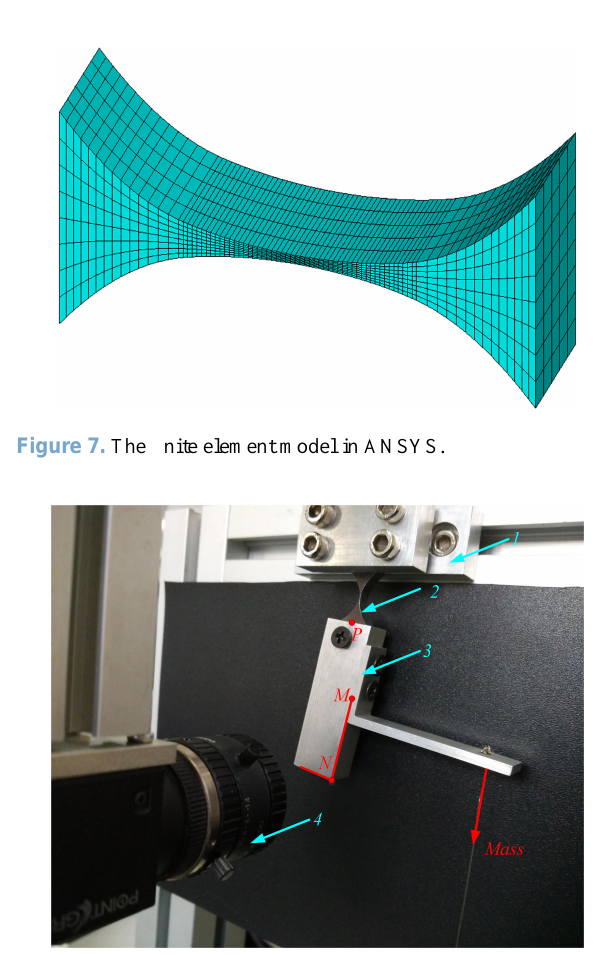
Figure 8. The experiment setup. (1: the base; 2: the flexure